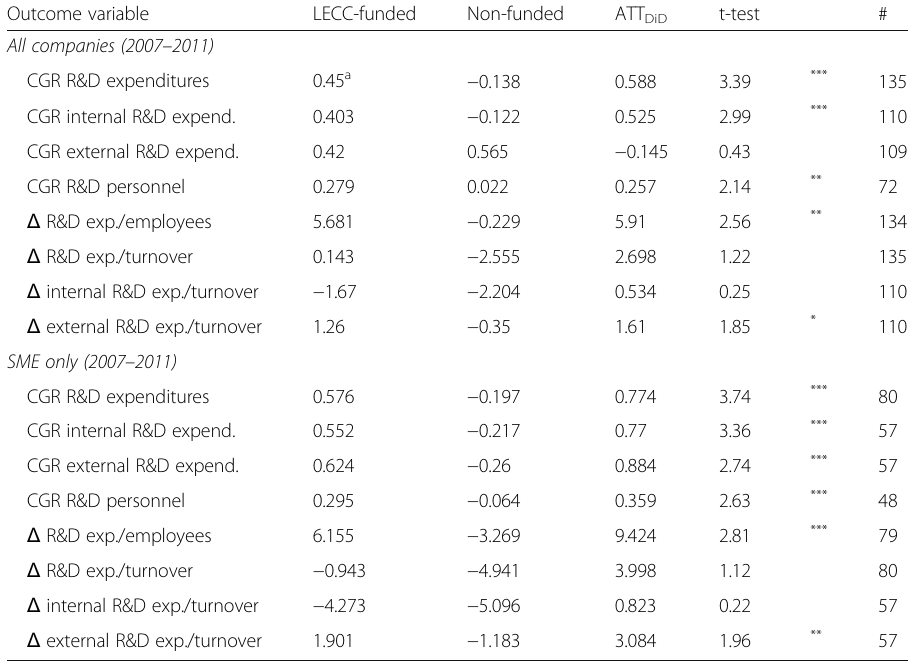
Table 1 Group comparison after matching (LECC funded vs. non-funded, mean values) Outcome